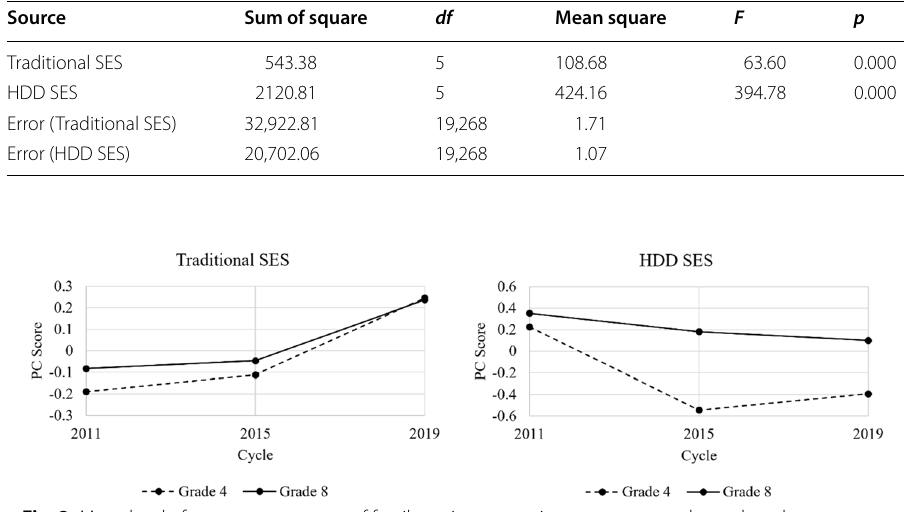
Fig. 2 Mean level of components scores of family socio‑economic status across cycles and